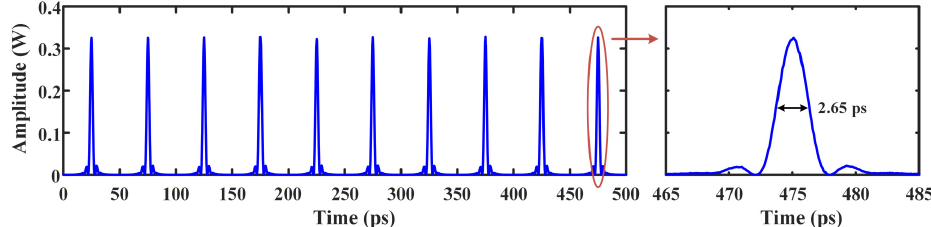
Figure 5. High-speed uniform optical pulse train generated from the cavity-less ultra-short optical pulse